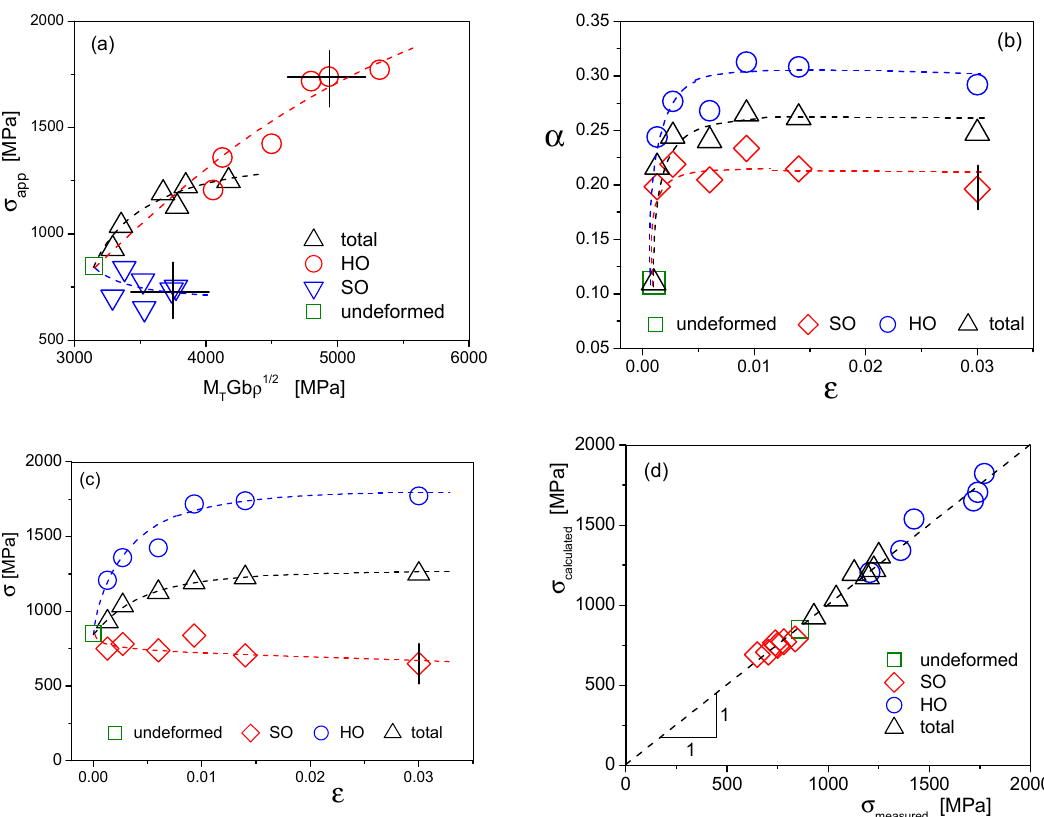
Figure 9. ( a ) The applied stress values versus M T Gb (cid:3493) for the measured values of the total, the hard, and the soft component dislocation densities, ( b ) the total α parameters and the local α values in the HO and SO components as a function of true strain, ( c ) the total and the local flow stresses corresponding to the HO and SO packets versus the true strain. The vertical thick black line indicates the experimental error. ( d ) The calculated local flow stress values in the SO and HO components and the total flow stress values vs. the corresponding measured values.